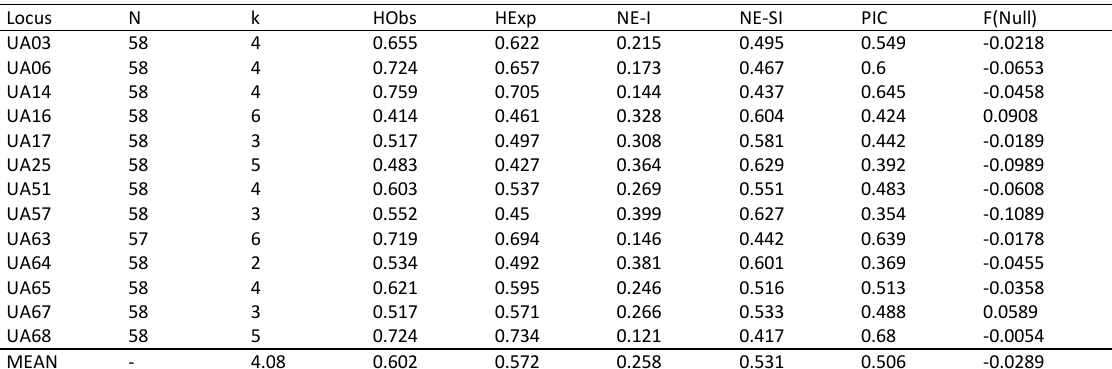
Table S4: Summary statistics of the 58 different genotypes found in the Pyrenean brown bear population in 2020 for each of the 13 microsatellite loci provided by the allele frequency analysis of CERVUS software (Marshall et al. 1998).